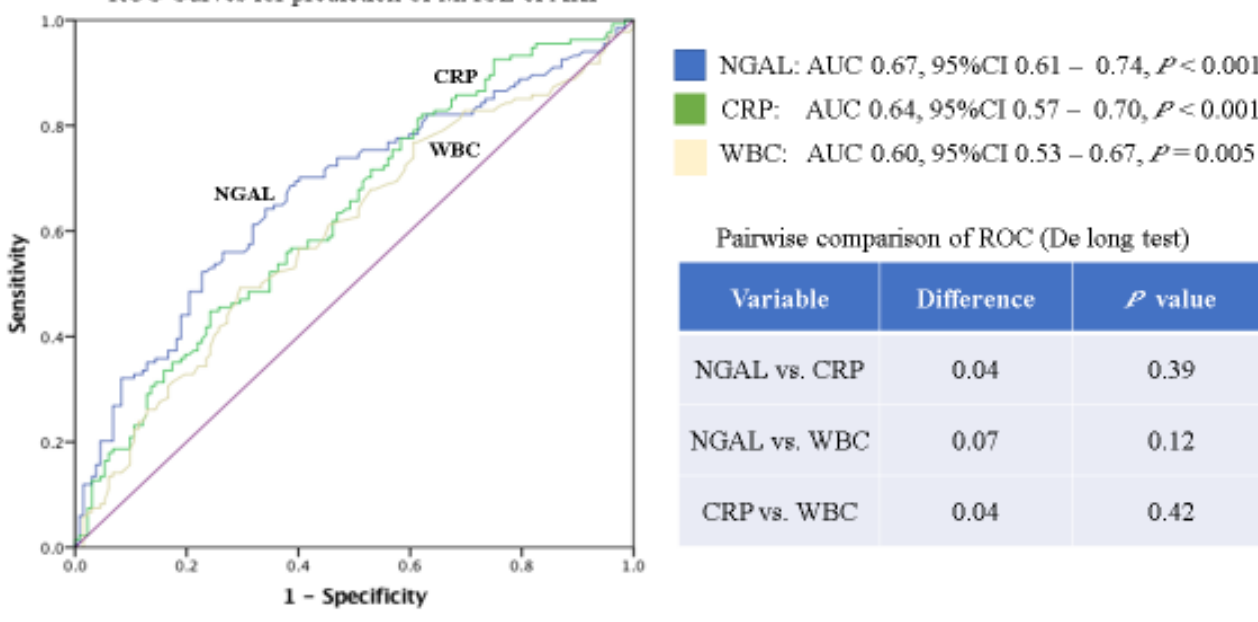
Figure 2. ROCs and corresponding AUCs of inflammatory laboratory markers for prediction of AKI; NGAL, neutrophil gelatinase-associated lipocalin; CRP, C-reactive protein; WBC, white blood cells.